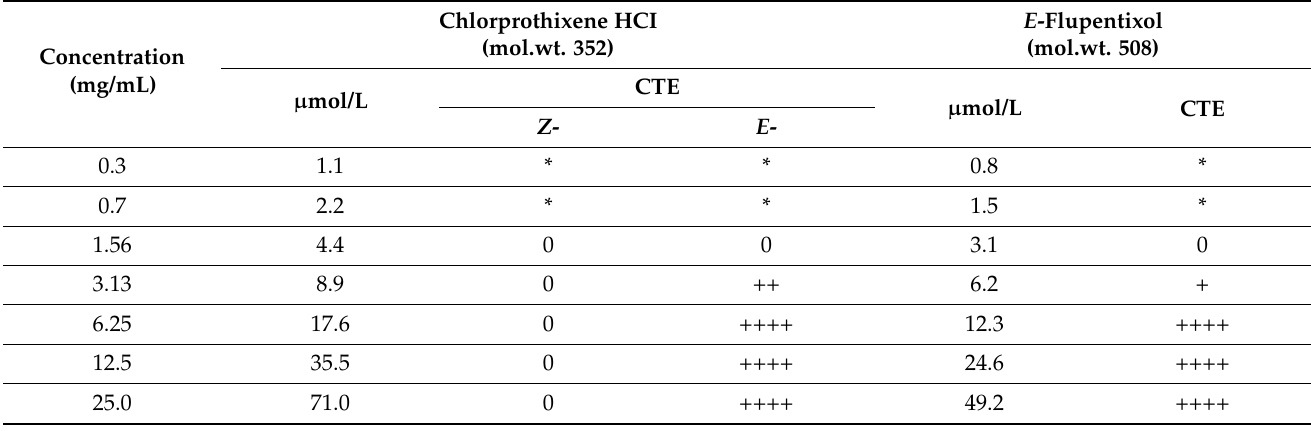
Table 9. Cytotoxic effect of